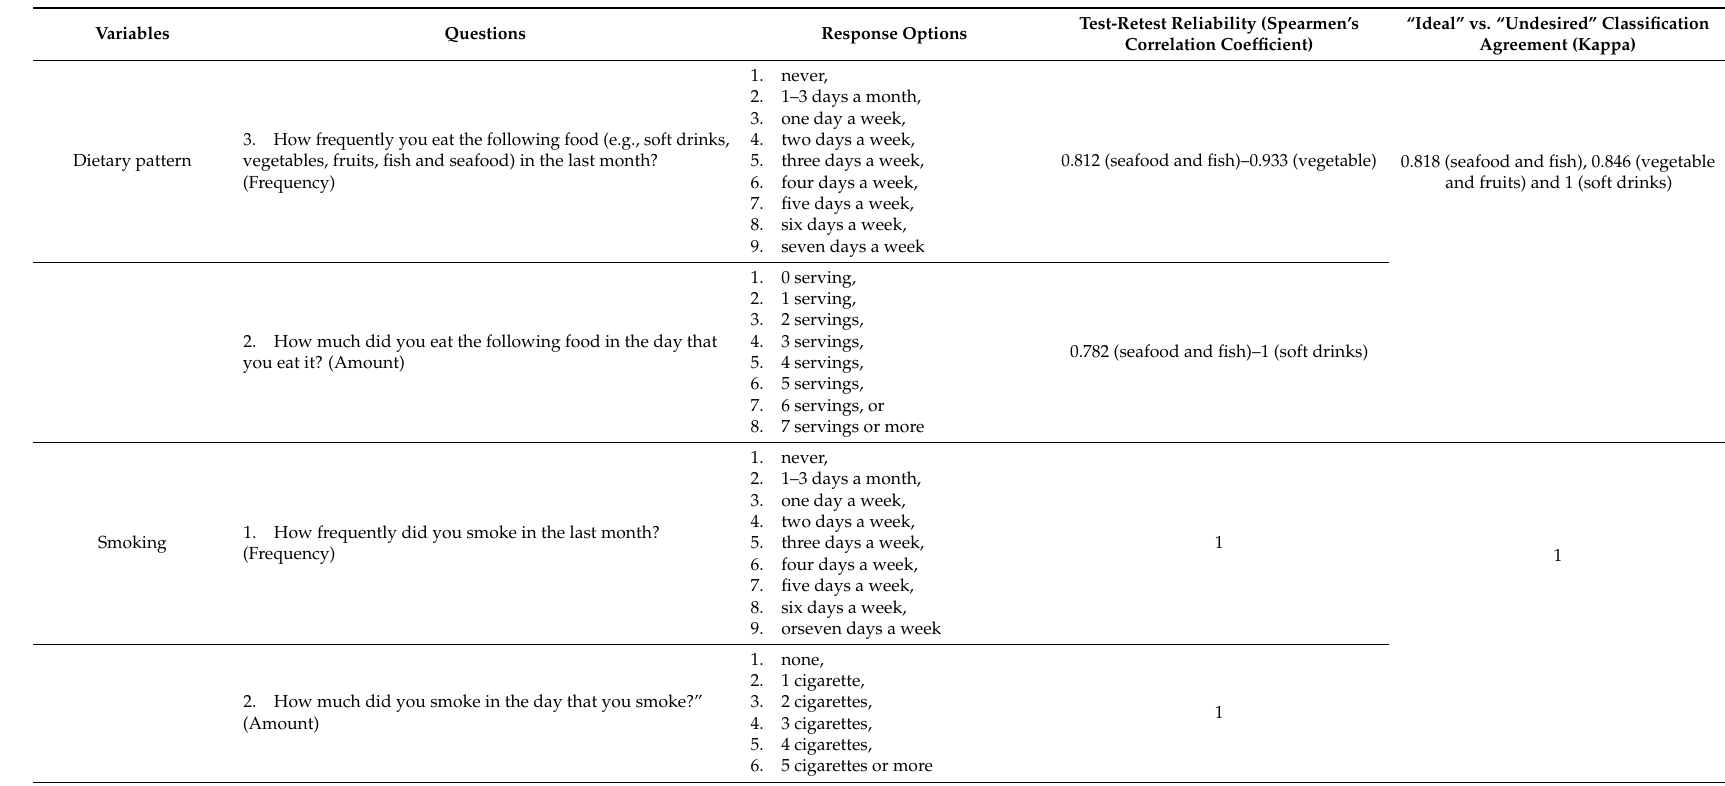
Table A1. Health Behaviors’